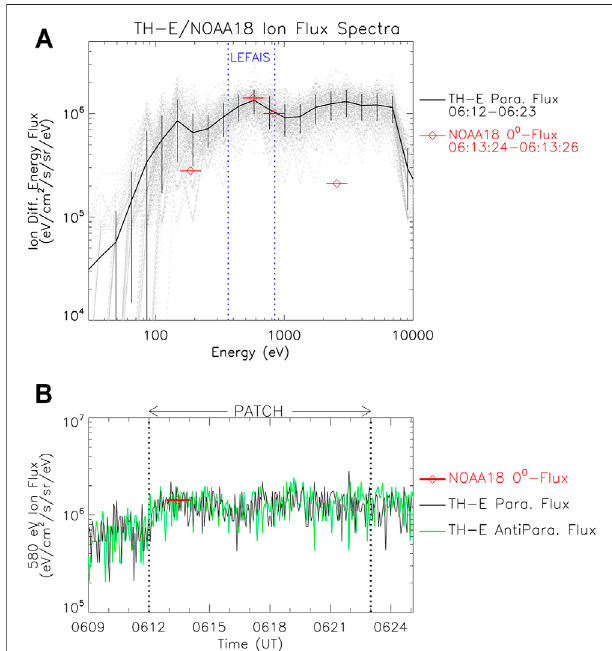
FIGURE 5 | (A) Ion parallel fl ux spectra sampled on NOAA18 and THEMIS-E during their respective PPA traversal intervals. For NOAA18 data, thereddiamondmarksthecenterenergy,whilethehorizontalbardenotesthe energy band. For THEMIS-E data, the energy fl ux spectra observed within the interval 0612 – 0623 UT are plotted as gray curves and superimposed;athickdarkcurveandverticalbarsdenotethemeantrendand standard deviations of THEMIS-E fl ux spectra averaged over the above interval.Twoblueverticaldottedlinesmarktheenergybandofthelow-energy fi eld-aligned ion structure (LEFAIS) seen on THEMIS-E. (B) Black and green curves denote the parallel and antiparallel fl uxes of 580 eV ions observed by THEMIS-E; a red dashed line shows the 0 ° - fl ux of 580 eV ions observed by NOAA18 at 06:13:26